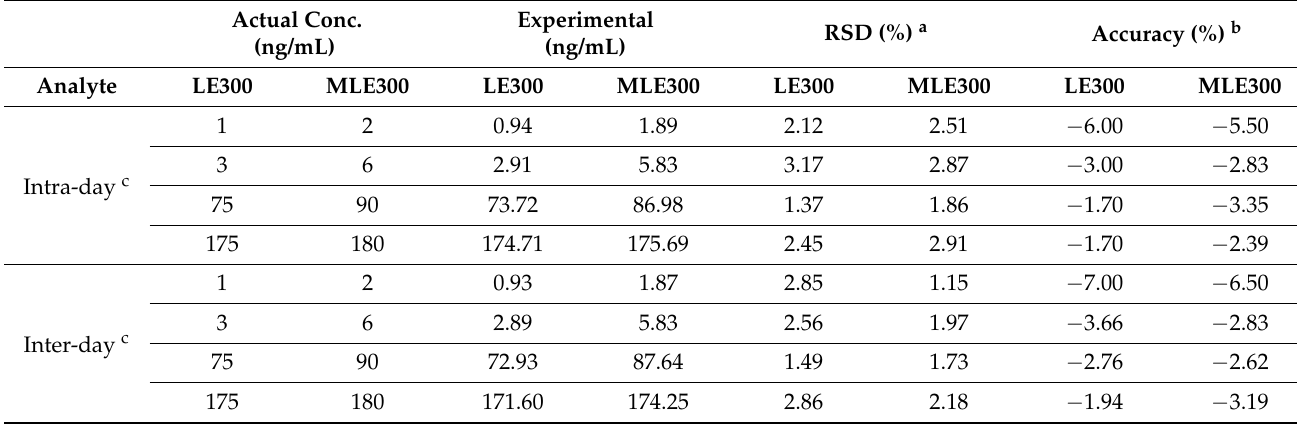
Table 4. Intra-day and inter-day precision and accuracy results of LE300 and MLE300 in rat plasma (Mean, n =